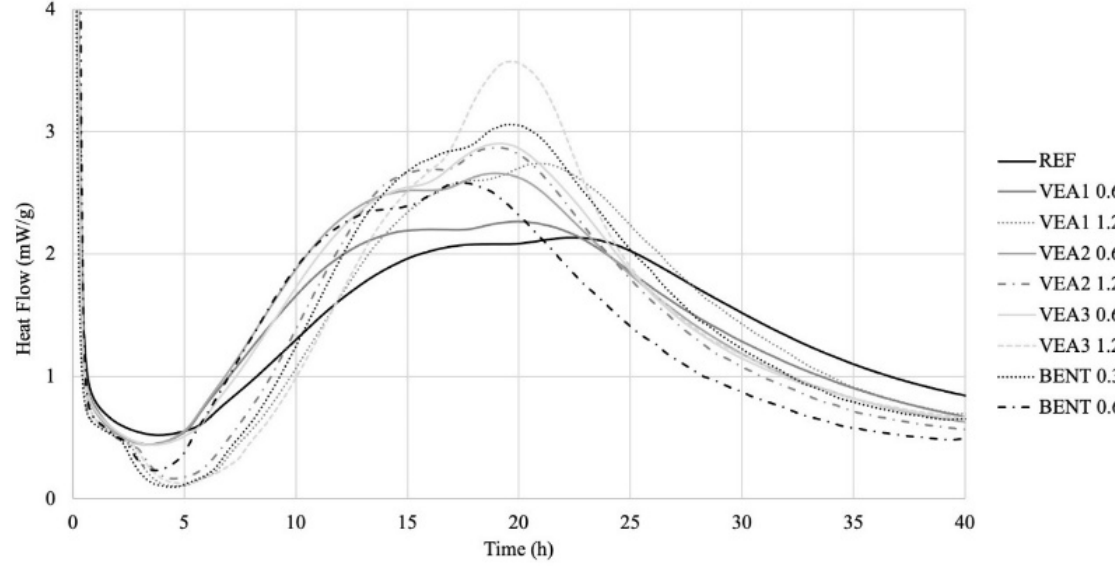
Figure 5. Heat flow over